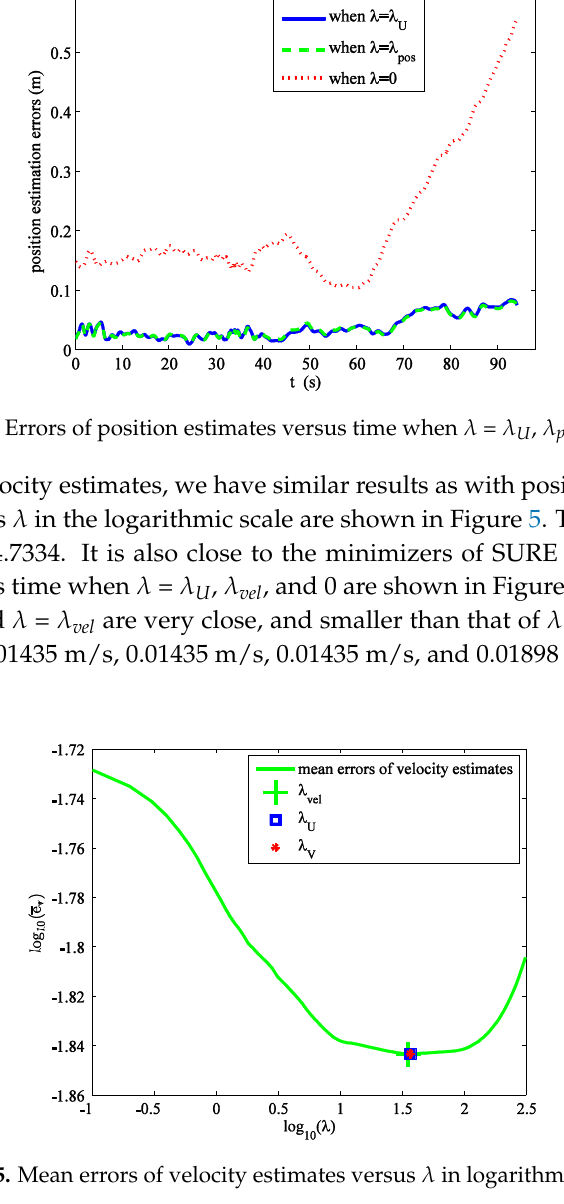
Figure 5. Mean errors of velocity estimates versus λ in logarithmic scale.